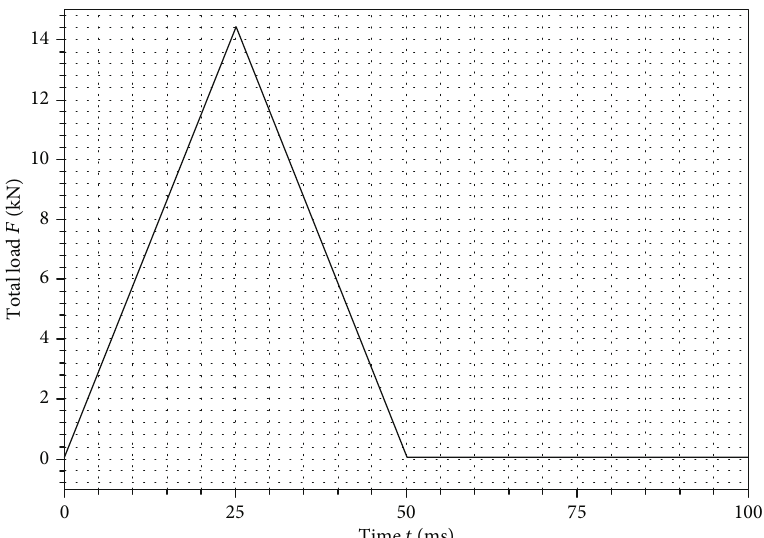
Figure 3: Load-time function of applied impulse.